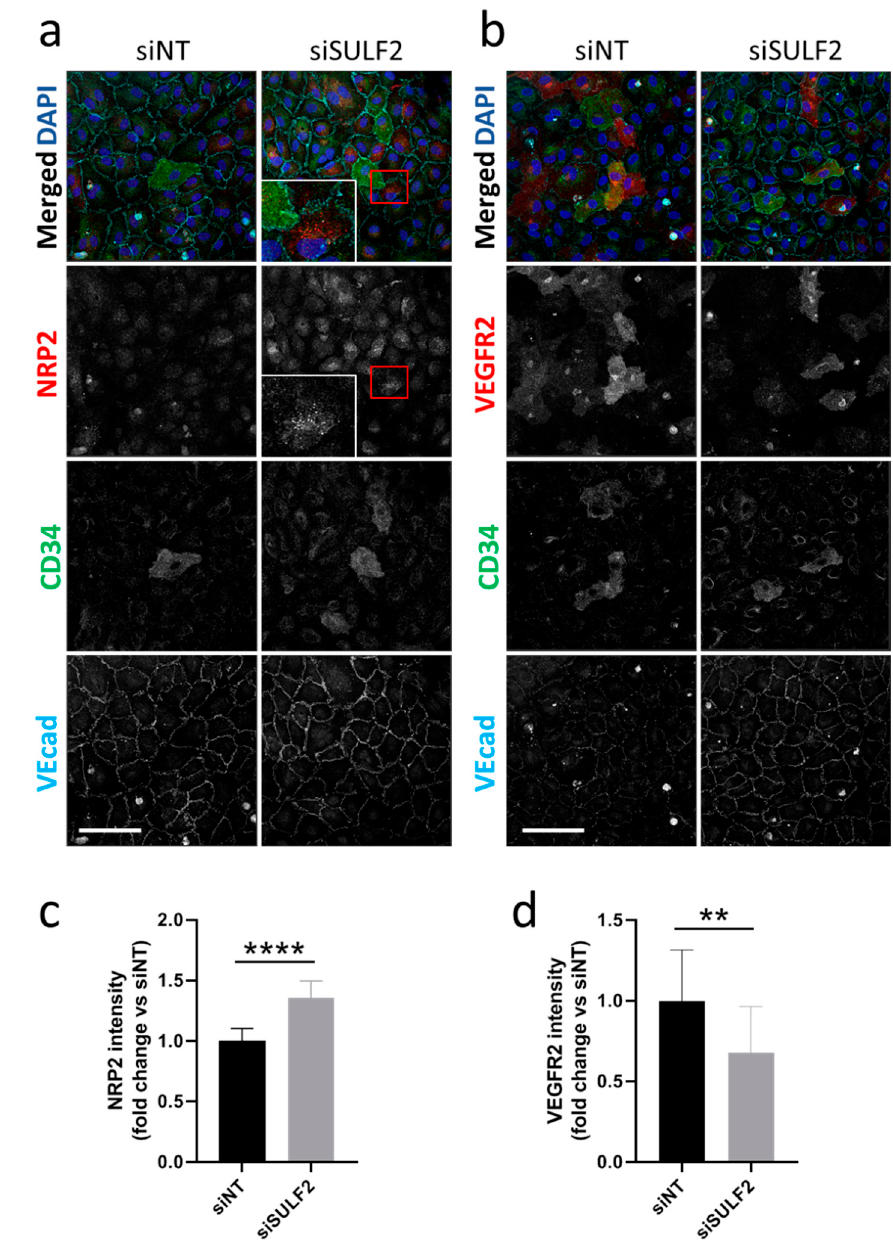
Figure 4. Changes in protein levels of NRP2 and VEGFR2 after SULF2 knockdown. HUVECs were transfected with si SULF2 or siNT as a control, seeded on coverslips and cultured for three days. After 2% PFA fixation, cells were stained with antibodies against ( a ) NRP2 or ( b ) VEGFR2 (red), CD34 (green), or VEcad (cyan) and with DAPI (blue). Representative images are shown for experiments on HUVECs of three donors. A 2.5-fold magnification of the area in the red box is presented. Scale bar = 50 µm. Quantification of NRP2 ( c ) and VEGFR2 ( d ) is shown below, relative to siNT with mean ± SD. ** p < 0.01, **** p < 0.0001.